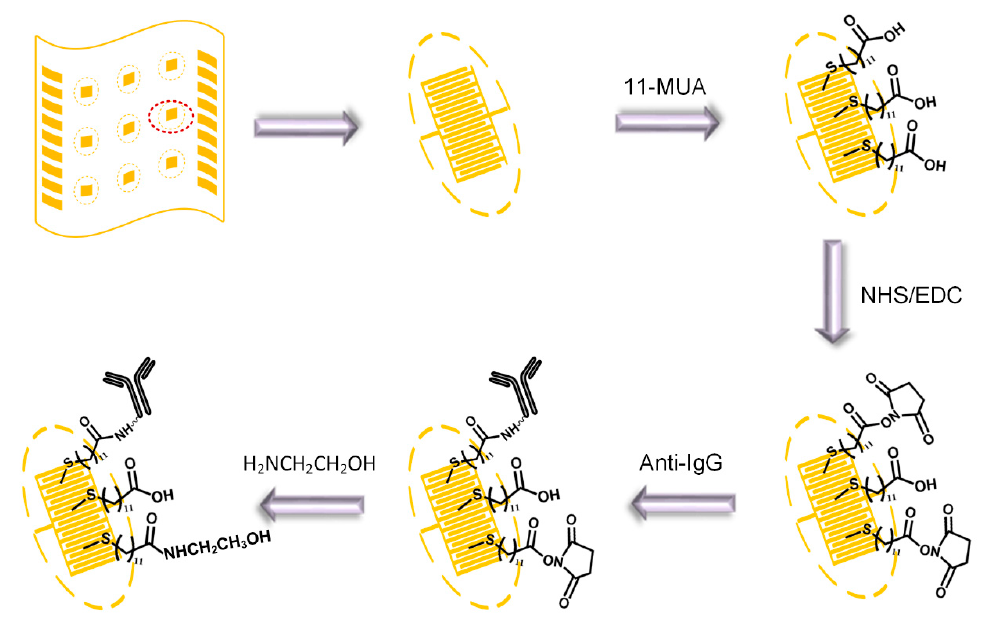
Figure 3. Shows the biofunctionalization steps of the interdigitated gold electrode.